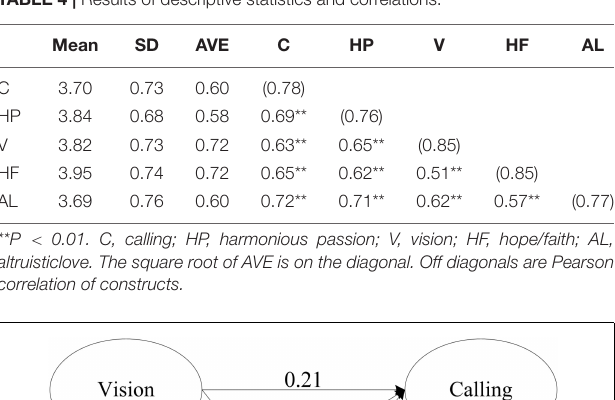
TABLE 5 | Path results for the final structural model (hypothesis